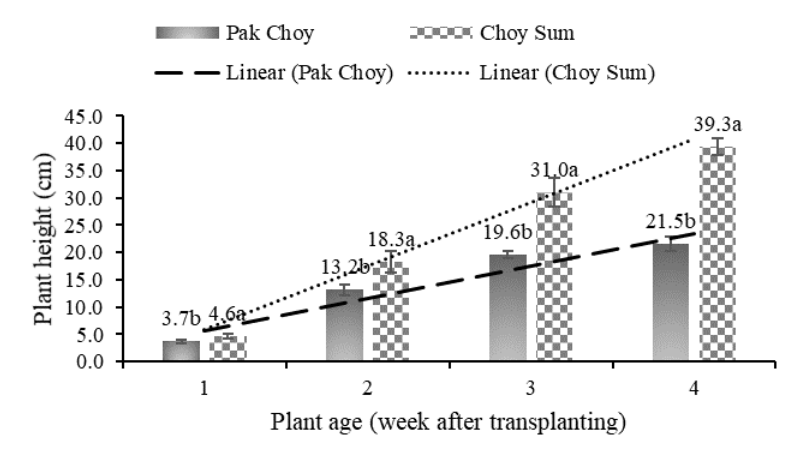
Figure 1 Plant Height on 2 Subspecies Brassica during plant growth. Values followed by the same letter in the same age are not significantly different (p < 0.05) by Duncan's multiple range test at 5%